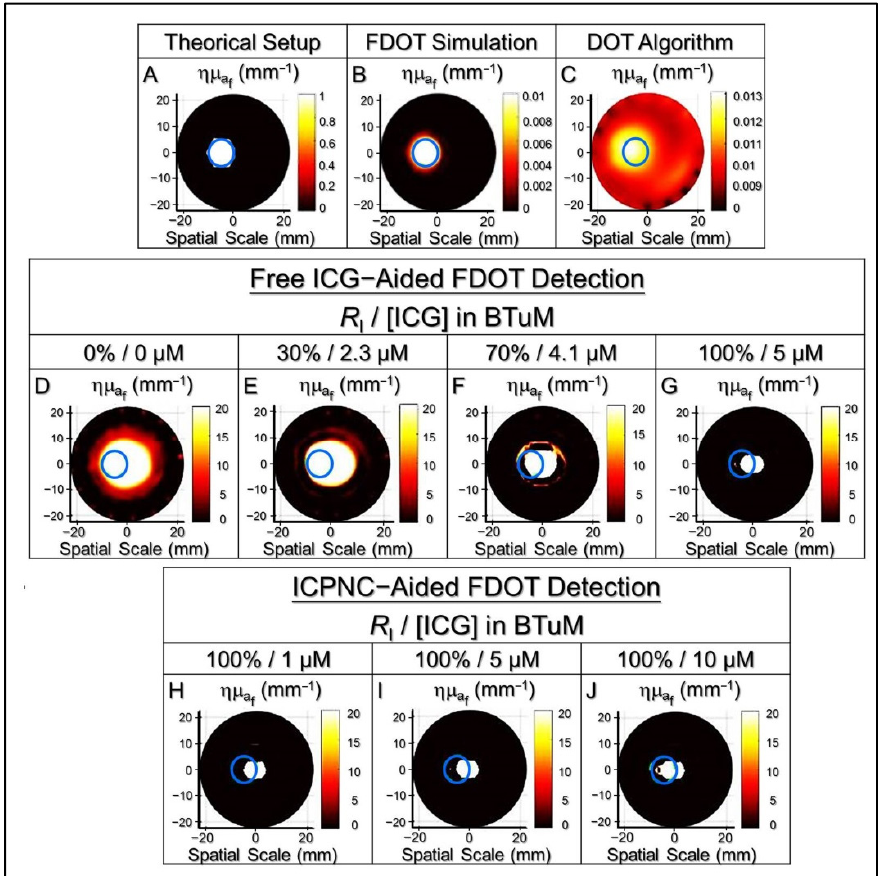
Figure 5. Image reconstructions of BTiM and BTuM using free ICG or ICPNCs as the NIR contrast agent. A–J represent the reconstructed images gained by FDOT or DOT with various conditions as indicated in the figure. The blue circle denotes the true position of the BTuM in each image determined based on the known experimental settings. Table 3. Effect of FDOT detection using free ICG or ICPNCs as the NIR contrast agent in the phantom. Groups